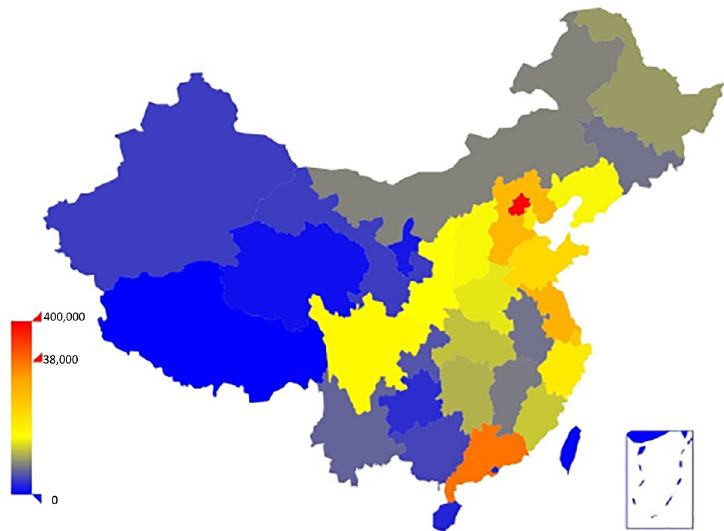
Figure 4. The viewing distribution of a hot message originated from Beijing